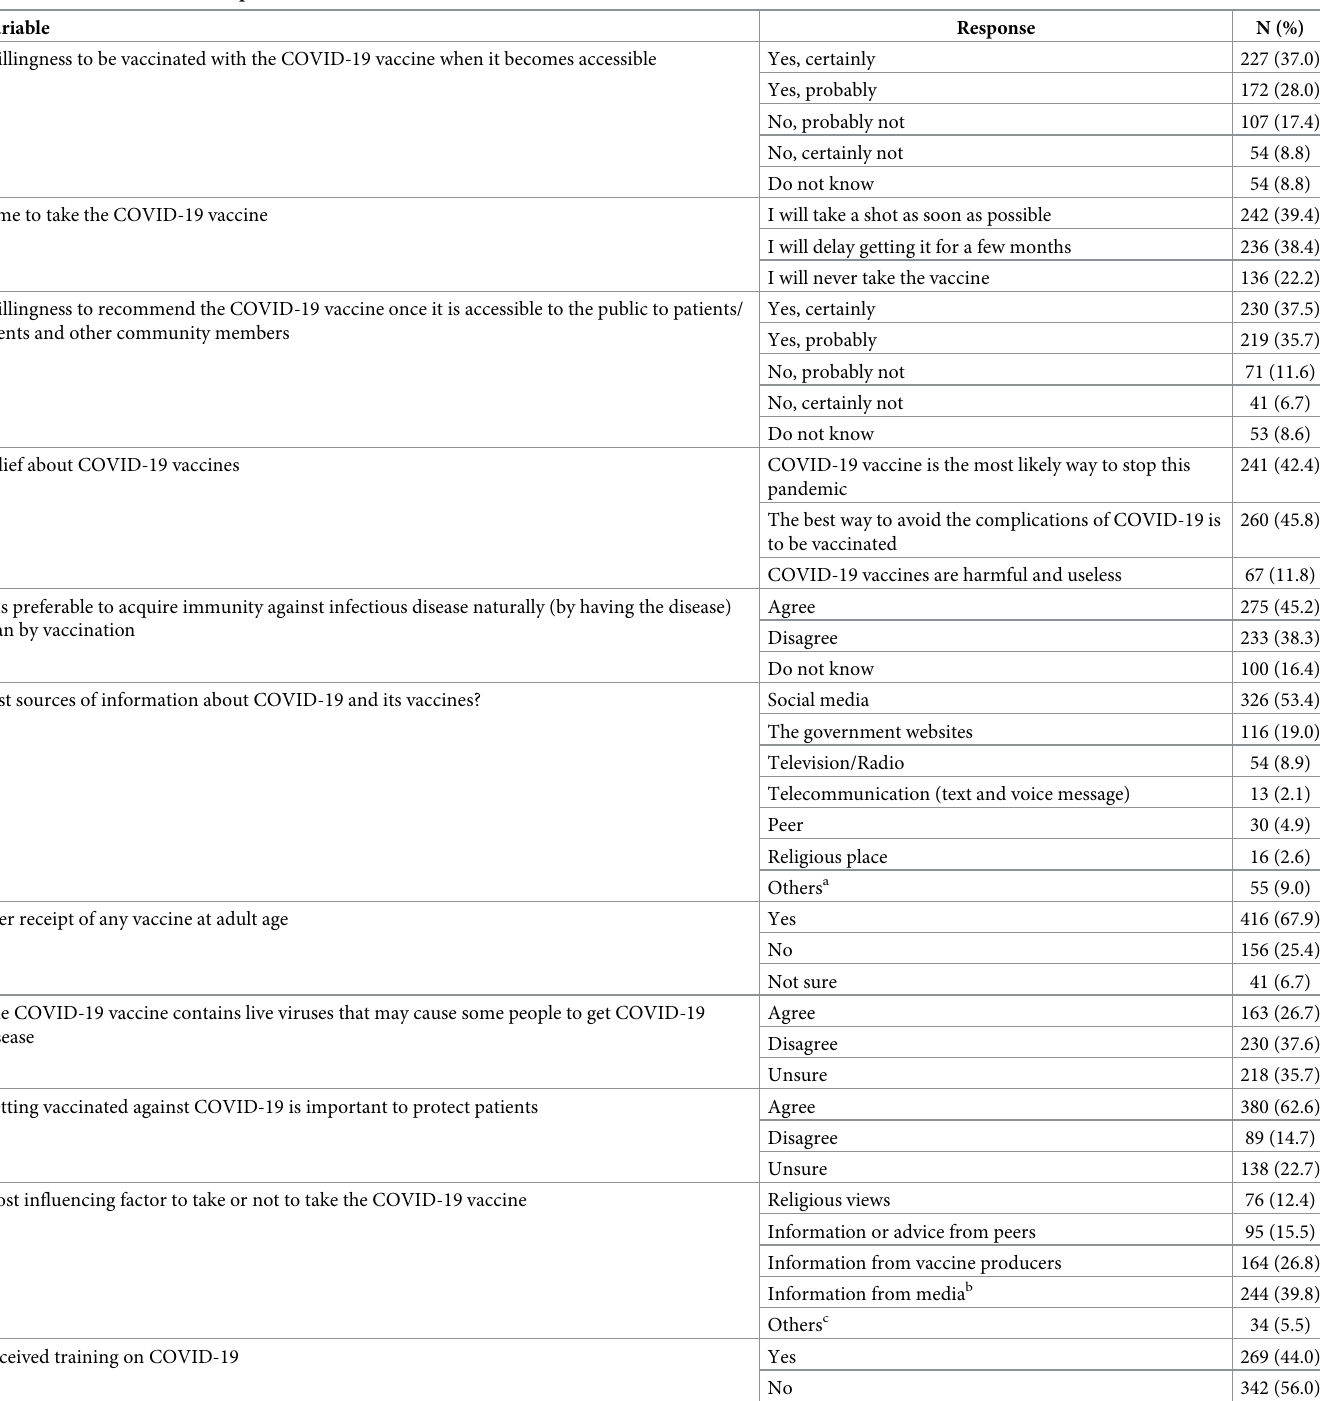
Table 4. Attitude of healthcare providers towards COVID-19